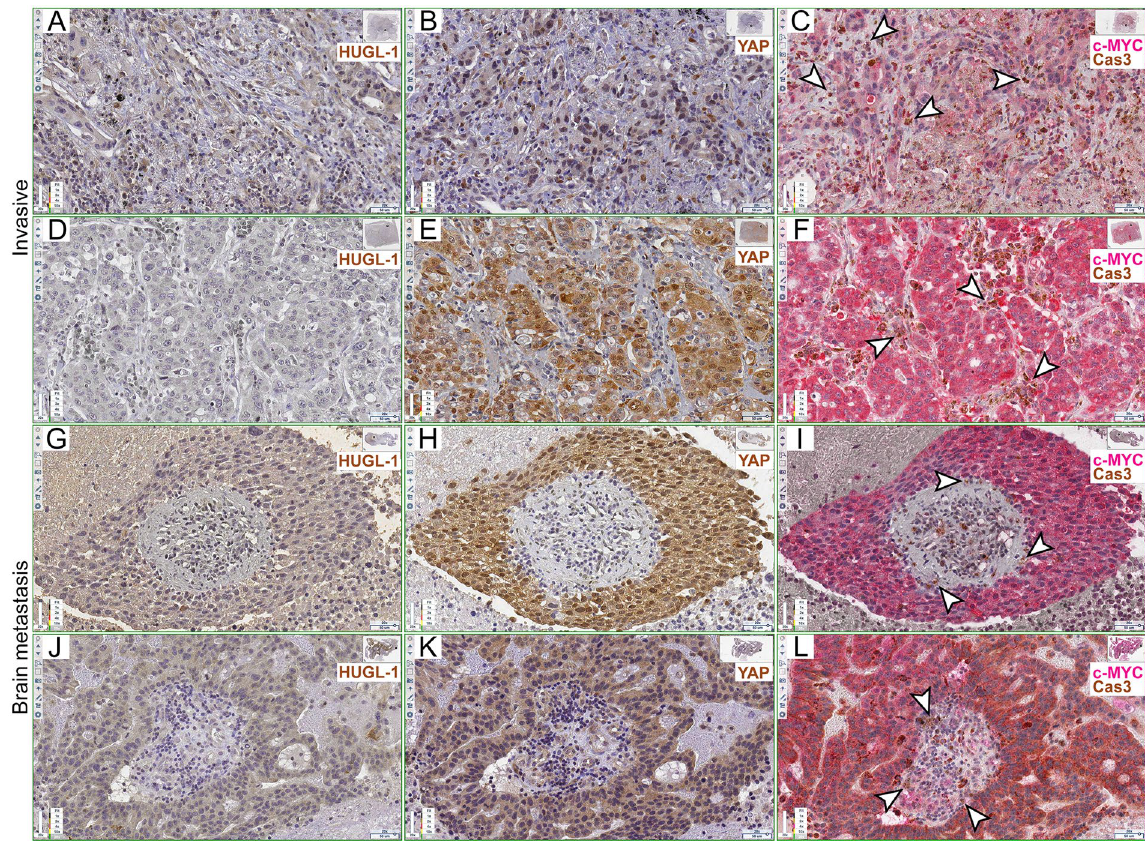
Figure 3. Human lung cancers show Caspase 3-positive stromal cells at the tumour border. ( A – F ) HUGL-1 ( A , D ), YAP ( B , E ) and c-MYC/Cas3 ( C , F ) staining of invasive carcinomas. The arrowheads in ( C and F ) highlight some stromal cells positive to Cas3 staining. ( G – L ) HUGL-1 ( G , J ), YAP ( H , K ) and c-MYC/Cas3 ( I , L ) staining of metastatic tumours. The arrowheads in ( I and L ) indicate Cas-3 positive stromal cells. Scale bars are indicated in each